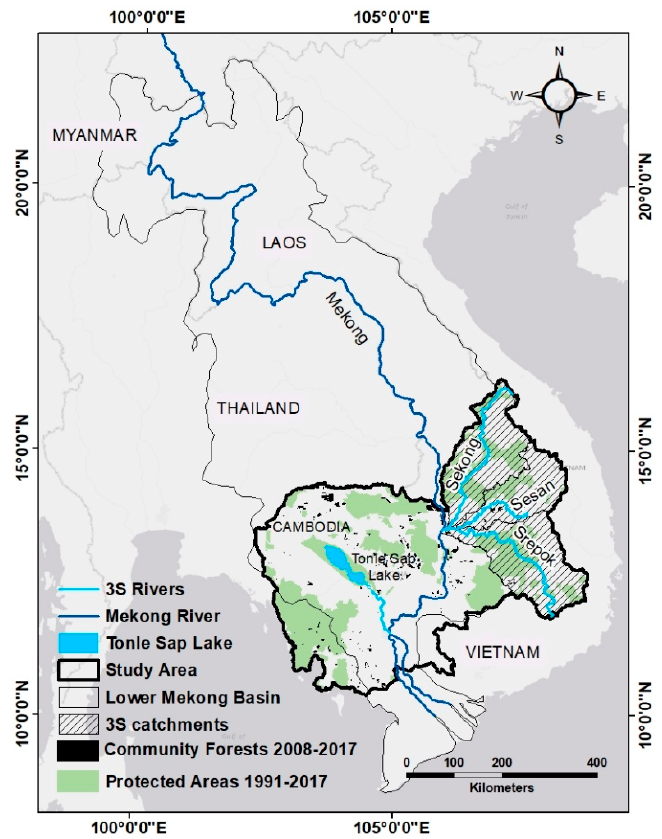
Figure 1. Study area including Cambodia and the Srepok, Sesan, and Sekong River watersheds, which include portions of Vietnam and Laos.